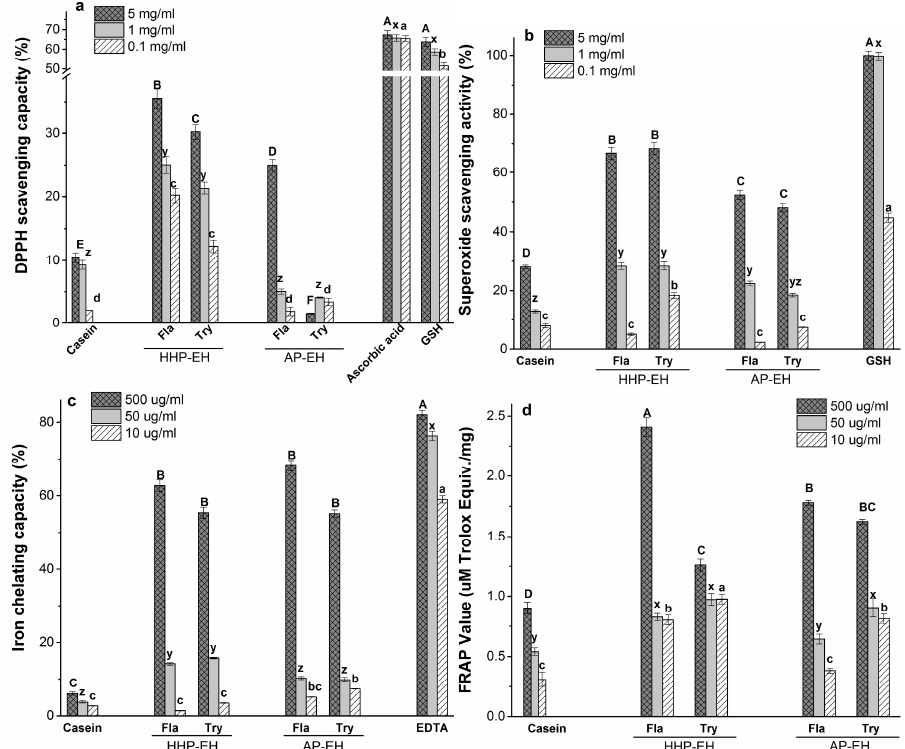
Figure 3. 1,1-Diphenyl-2-picryl Hydrazyl (DPPH) scavenging capacity ( a ); Superoxide radical scavenging activity ( b ); Iron chelation capacity ( c ) and f erric r educing a ntioxidant p ower (FRAP) values ( d ) of